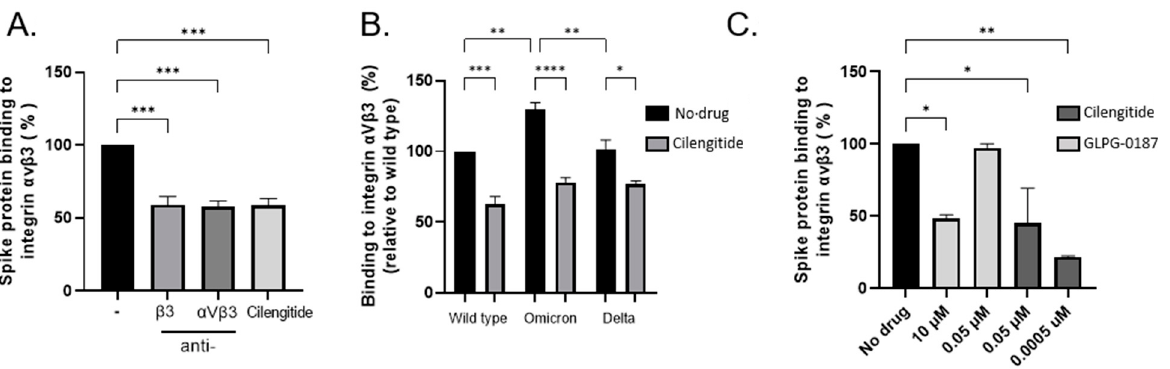
Figure 1. Wild type, Delta, and Omicron spike proteins bind integrin α V β 3 through its RGD site. ( A ) Binding of SARS-CoV-2 spike protein to recombinant integrin α V β 3 in an ELISA-based assay. Integrin-blocking antibodies α V β 3 and β 3 inhibit the interaction between recombinant spike protein and α V β 3, similarly to Cilengitide (0.0005 µM) (One-way ANOVA, *** p < 0.001). ( B ) Effects of Cilengitide on variants of concern Delta and Omicron spike proteins binding to integrin α V β 3 (One-way ANOVA, * p < 0.05, ** p < 0.01, **** p < 0.0001). ( C ) Effects of broad-spectrum pan integrin inhibitor GLPG-0187 on spike protein binding to integrin α V β 3, compared to Cilengitide (One-way ANOVA). Values are mean ± S.E.M., n = 3.